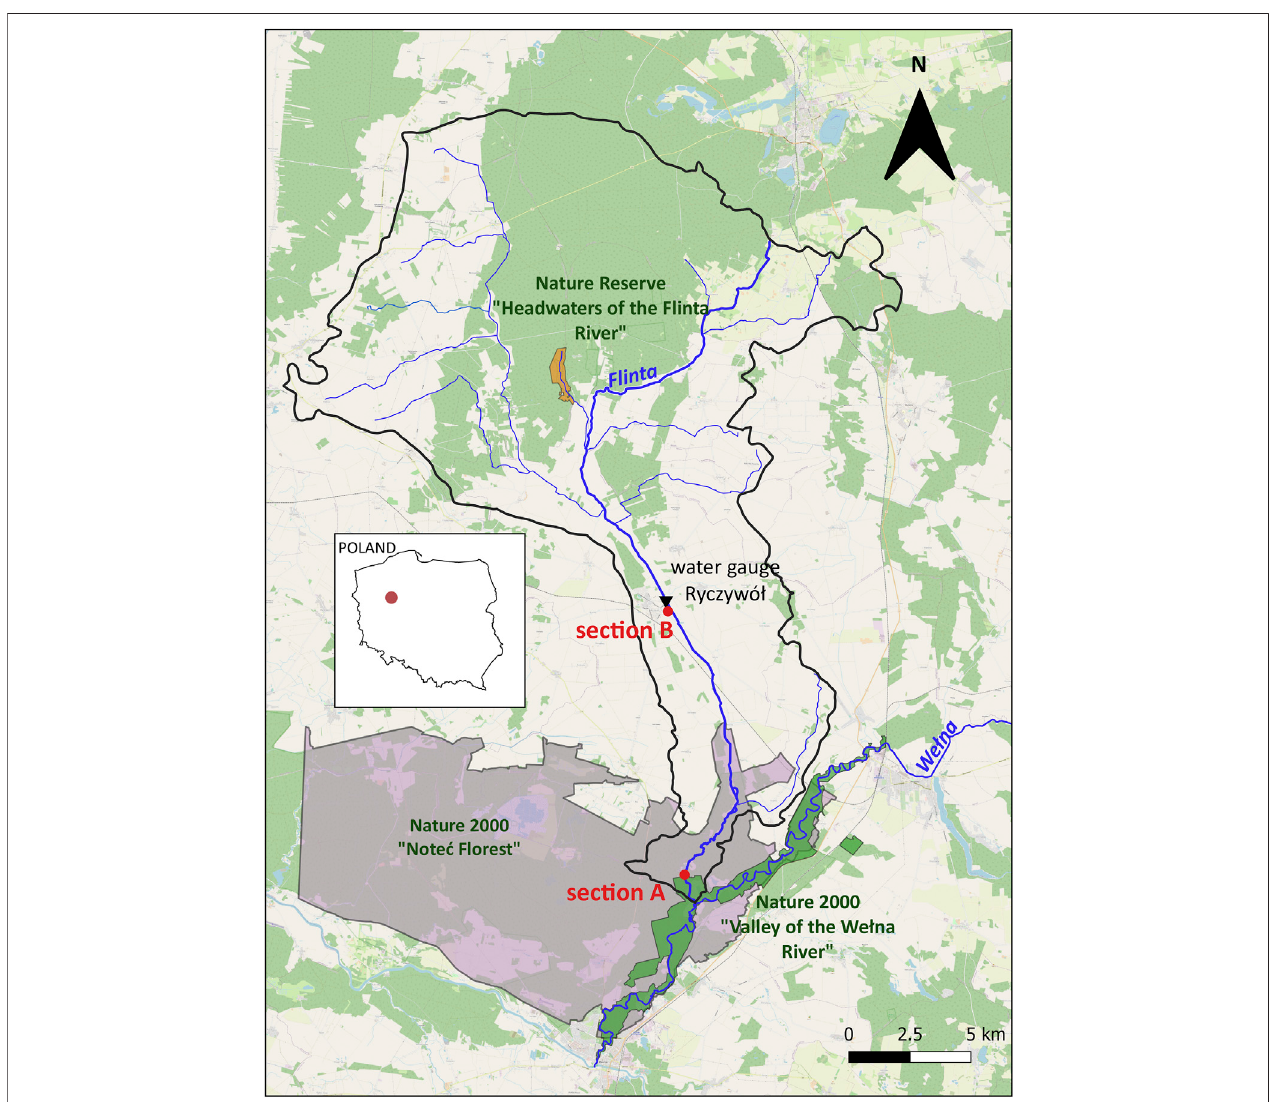
FIGURE 1 | Location of the Flinta River catchment and the studied river